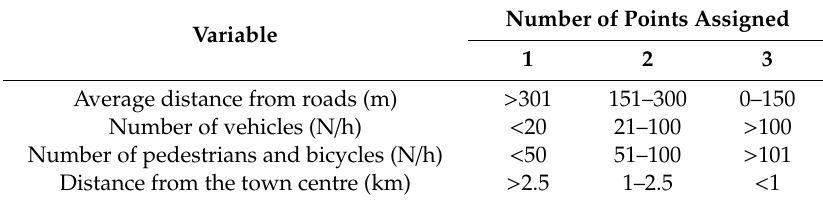
Table 1. Method of anthropopression assessment in woody plant species inventory transects, along the Gwda